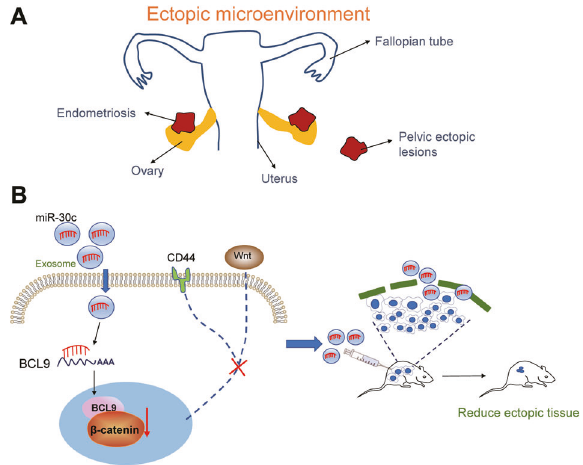
Fig. 6 The mechanism graph of the regulatory network and function of miR-30c. A The microenvironment of ovarian endome- triosis; B The mechanism graph of the regulatory network and function of miR-30c. miR-30c delivered by EECs-derived exosomes inversely regulated BCL9 expression, and blocked the Wnt/ β -catenin signaling pathway along with the downstream CD44 expression, thus contributing to the suppression of the invasion and migration of ecto-EECs in